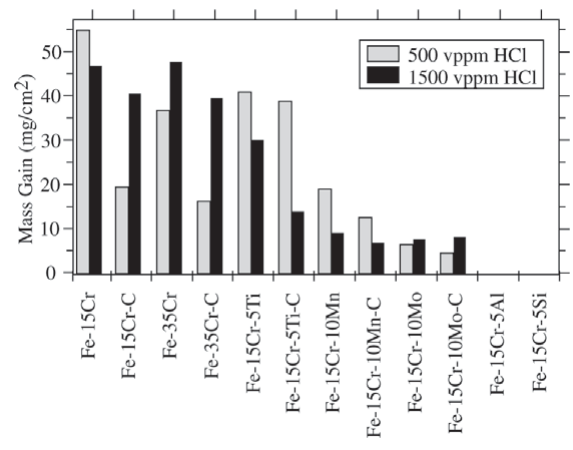
Figure 3. Mass changes of the model alloys after 168 h corrosion -5% O -500 or 1500 vppm in N 2 2